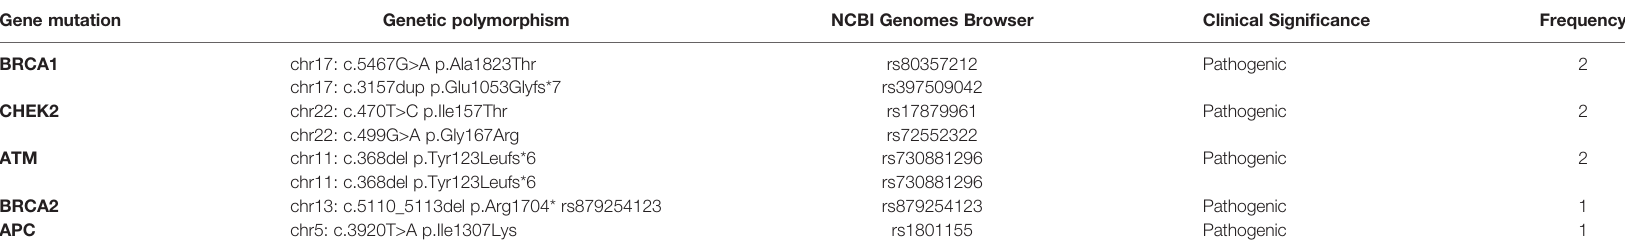
TABLE 5 | Germline pathogenic mutations of old patients (>40 years) with breast cancer as determined by NGS